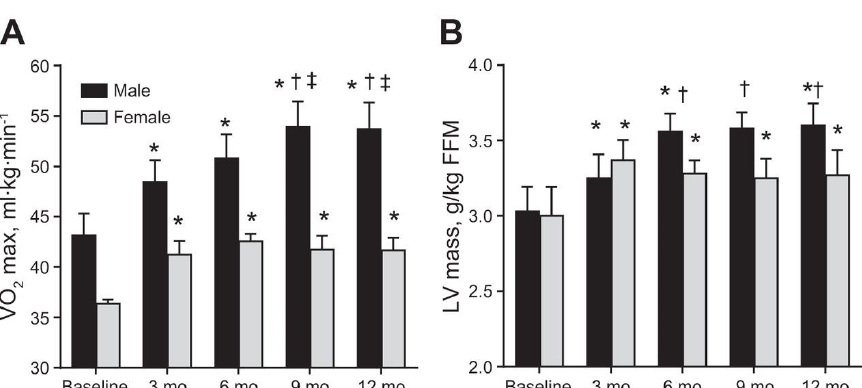
Figure 5. Reprinted with permission from ref. [64]. 2015 the American Physiological Society. ( A ) effect of 1 year of endurance training on VO 2max indexed to baseline body mass in males and females, ( B ) effect of 1 year of endurance training on changes in LV mass measured by MRI scaled to base-line fat-free mass. Post hoc comparison with baseline (*), with baseline, month 3 (†), and with month 6 (‡) for p < 0.05 from linear mixed model.